Question: Give a one-sentence summary of this figure.
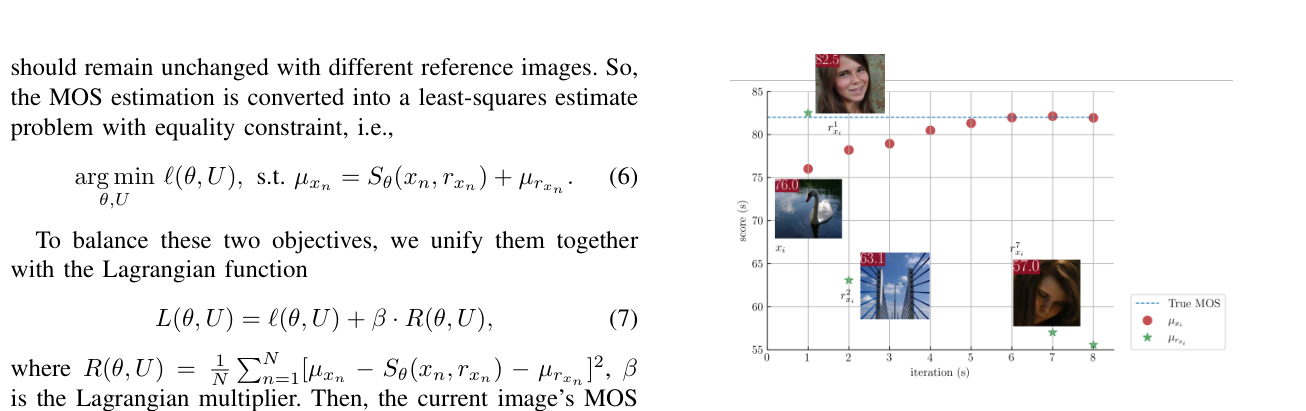
Answer: The variation of estimated MOS in the iterative update process of PC3.